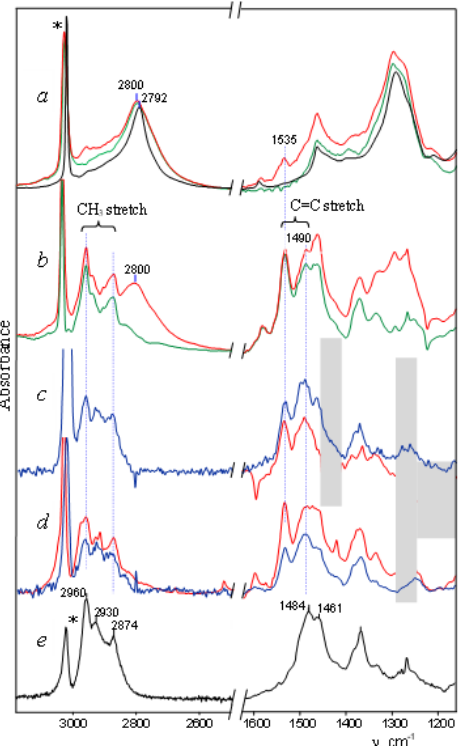
Figure 1. IR spectra of the saturated solutions of the t-Bu + {Cl 11 − } salt in various solvents (with subtracted spectra of the solvents): (a) d 4 -DCE (red) with a subtracted spectrum of the dissolved (CH 3 ) 2 C=CH + {Cl 11 − } salt (green); (b) d 2 -DCM (red) with a subtracted spectrum of the dissolved t-Bu + {Cl 11 − } salt (green); (c) 1,2-dibromoethane (red) and a solid from the evaporated solution (blue); (d) d 2 -1,1,2,2-tetrachloroethene (red) with a solid from the evaporated solution (blue). The black curve denotes the spectra of the crystalline t-Bu + {Cl 11 − } salt (a) and (CH 3 ) 2 C=CH + {Cl 11 − } salt (e). The asterisk indicates the band of the CH stretch in the anion. The solvent opacity region is shaded.